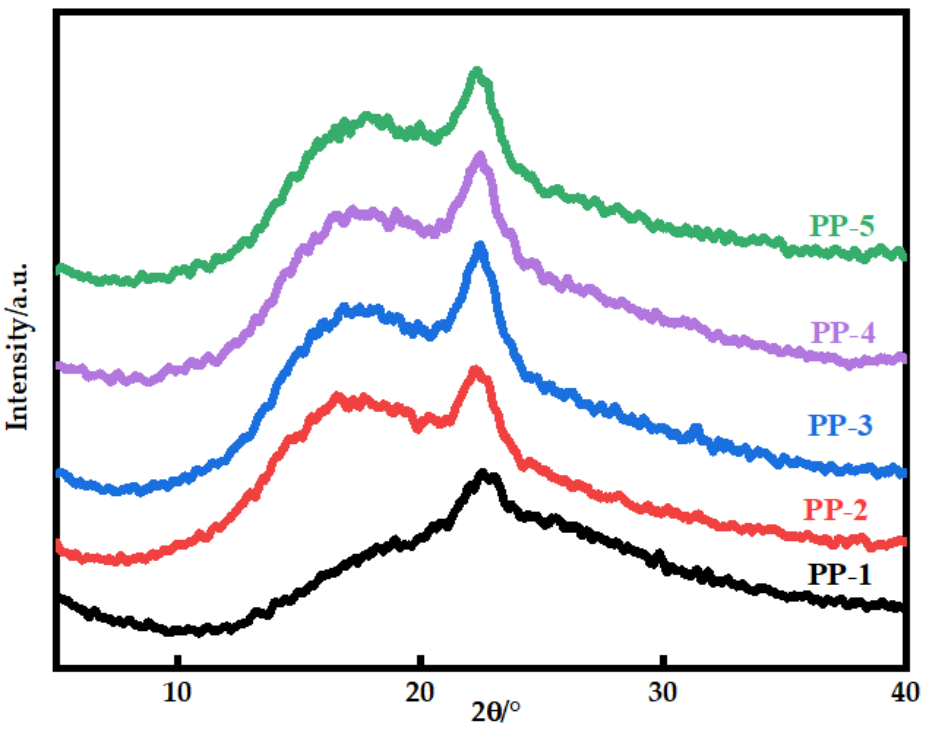
Figure 7. X-ray diffraction patterns of various PES/PEI membranes. Table 6. π–π stacking distance of various blend membranes.